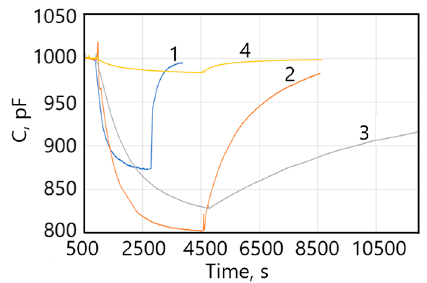
Figure 5. Responses capacitor sensor to 108 ppb NO 2 concentration at temperatures: 1—170 ° С ,